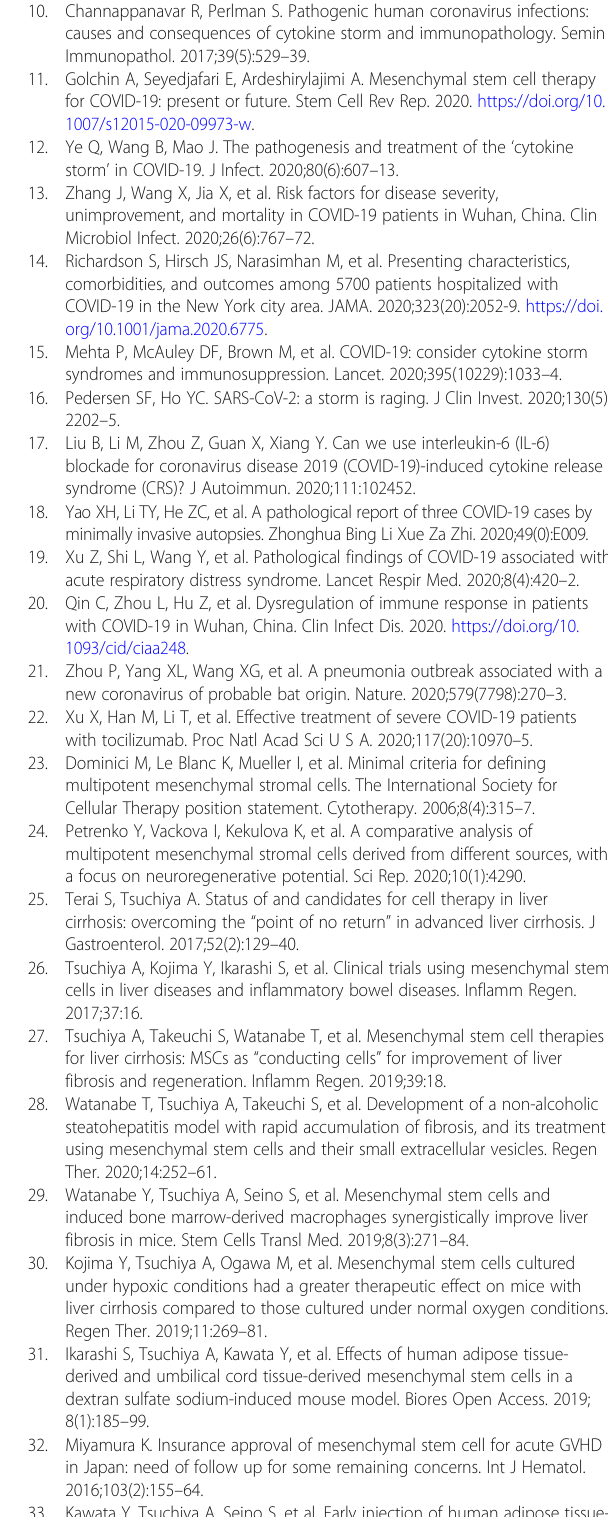
Additional file 1: Table S1. Clinical trials using mesenchymal stem cells (MSCs) and exosomes and registered on